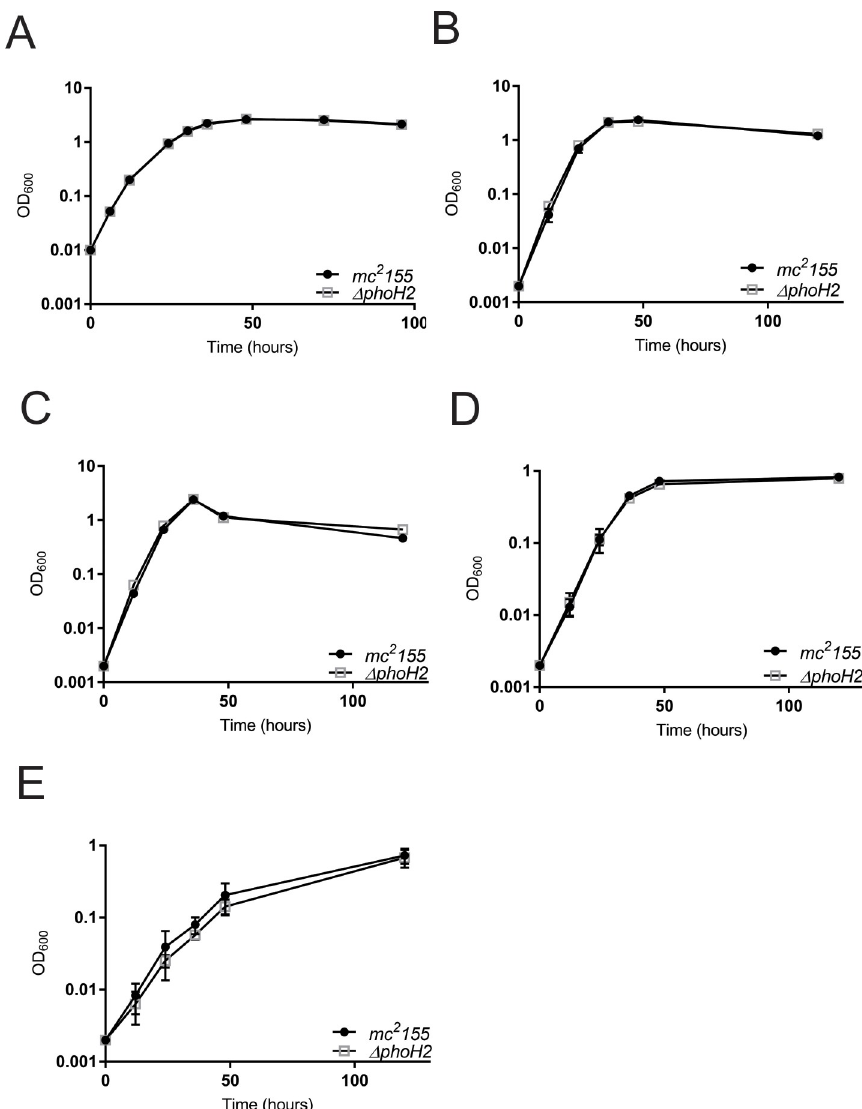
Fig 2. M . smegmatis mc 2 155 Δ phoH2 adopts the same growth profile as M . smegmatis mc 2 155 in rich, defined and nutrient limiting growth conditions. M . smegmatis mc 2 155 (closed circles) and M . smegmatis mc 2 155 Δ phoH2 (open squares) were cultured in (A) LB, (B) Sautons, (C) Sautons—carbon limiting, (D) Sautons—nitrogen limiting and (E) Sautons—phosphate limiting media. Growth was measured by monitoring optical density (OD 600 ) at regular intervals. Data were plotted as the mean and SD of three biological replicates of each strain and an unpaired t-test was used to test for significant differences between the strains. Plots show that M . smegmatis mc 2 155 Δ phoH2 adopts the same growth profile as its parent in rich, defined and nutrient poor conditions. (Plots generated and analysed in Prism V7).